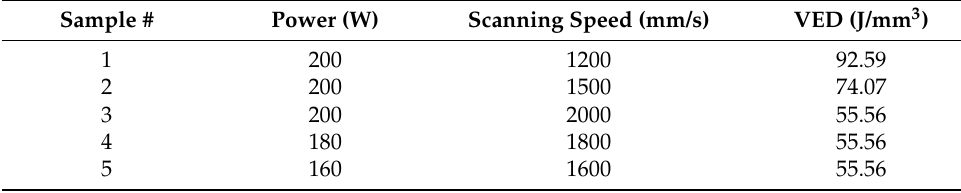
Table 2. Process parameters of the LPBF-built AlCoCr 0.75 Cu 0.5 FeNi